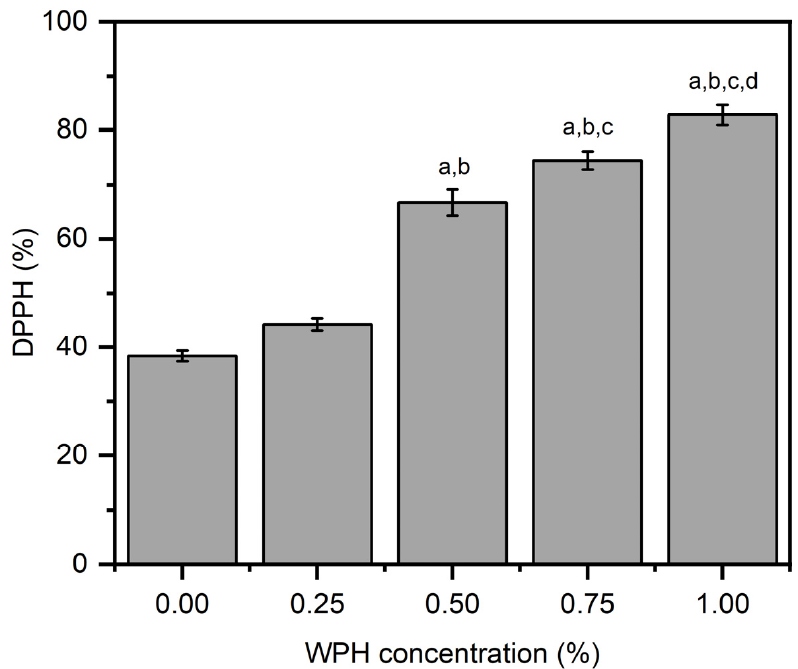
Figure 4. DPPH radical of chitosan/WPH films containing different concentrations of WPH. Data are presented as an average of three measurements ± standard deviation. Values with different letters on the top of bars are significantly different ( p < 0.05) and determined by using a Bonferroni post hoc test in a one-way ANOVA analysis—a, b, c, d are relative to films comprising 0 wt%, 0.25 wt%, 0.5 wt% and 0.75 wt% WPH, respectively.